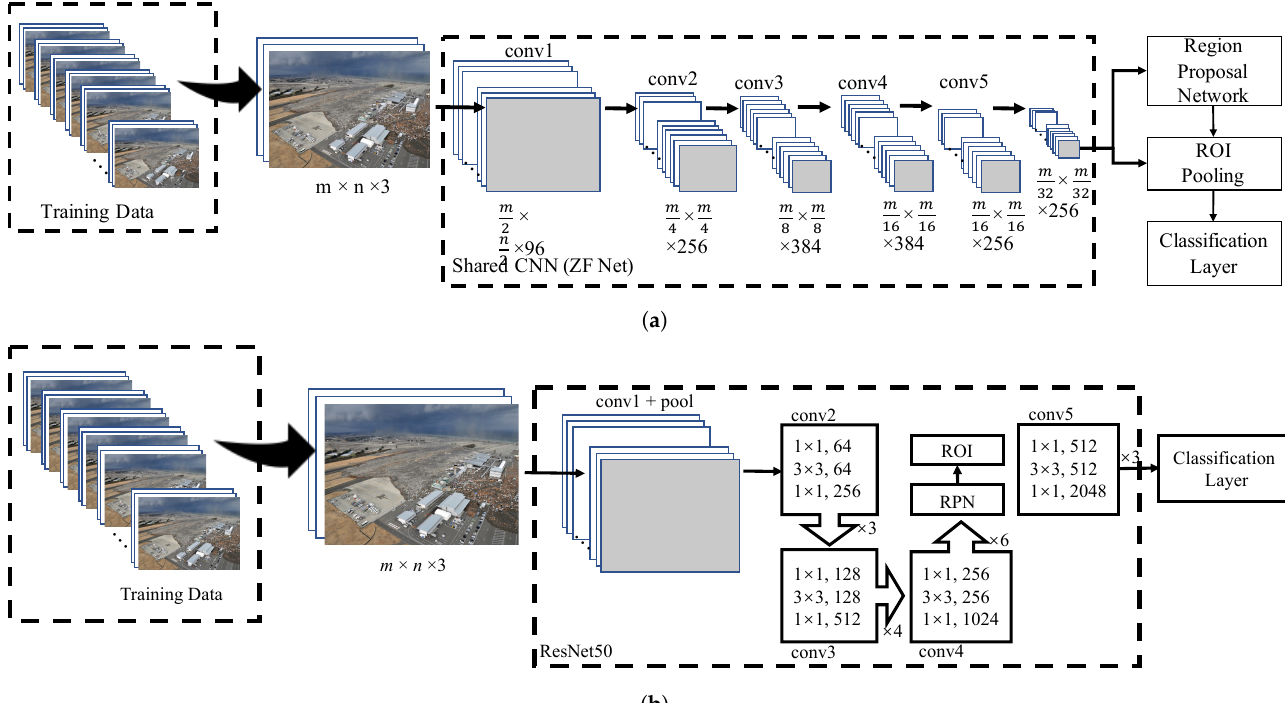
Figure 4. Modified Faster R-CNN models: ( a ) using a ZF network as feature extractor; and ( b ) using a ResNet-50 as feature